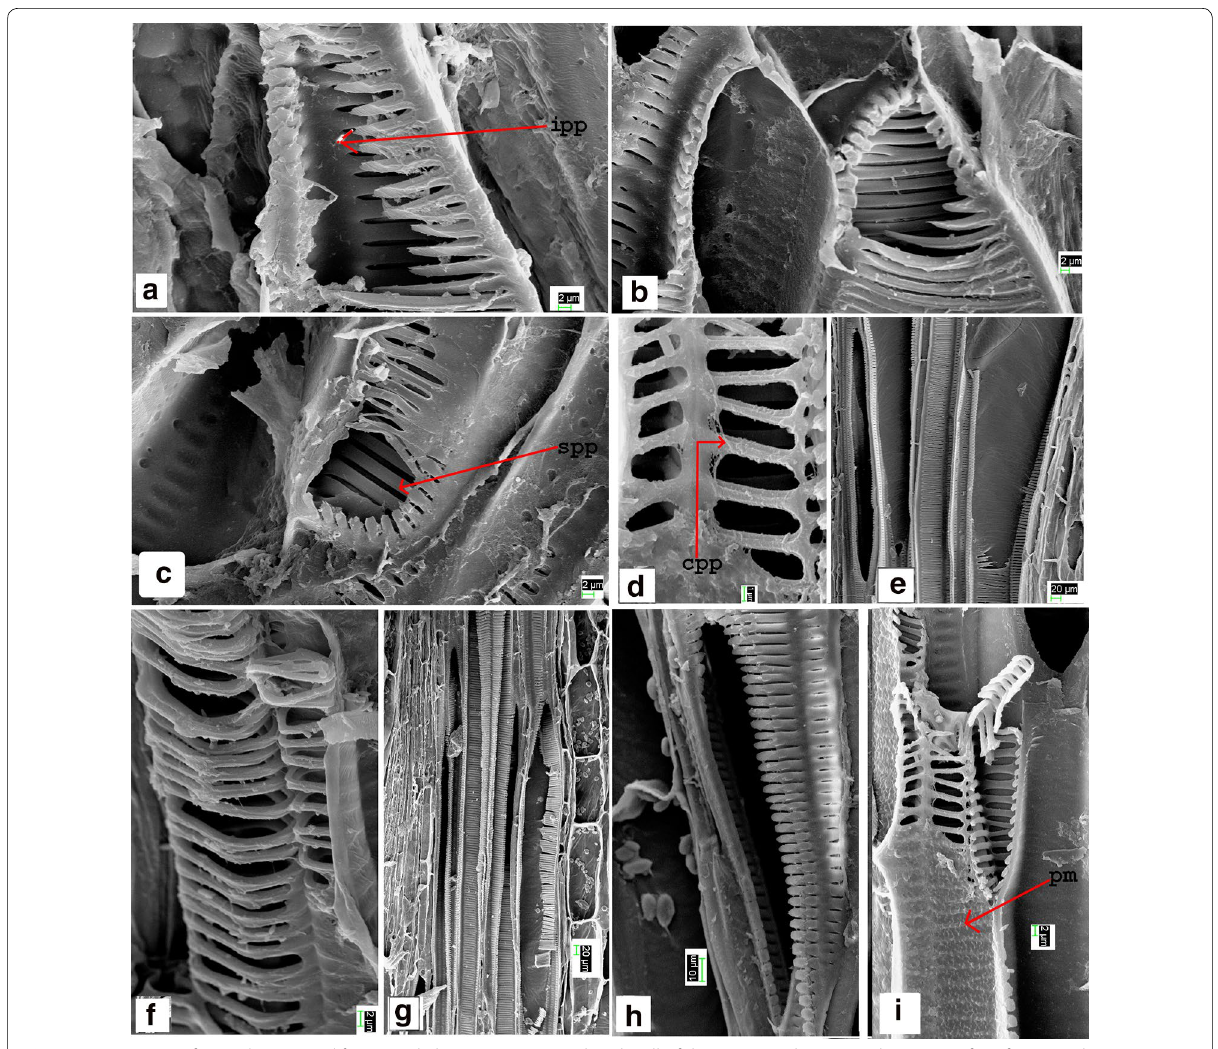
Fig. 4 SEM images of Ampelopteris prolifera -vessel elements. a – c Vessel end wall of rhizome a with intermediate type of perforation plate, scalariform bars half produced b with 2–3 remnant scalariform bars. c Simple perforation plate, d vessel endwall (root) with complex perforation plate. e Vessel element (rhizome) with elongated perforation plate. f Helically thickened tracheid. g Vessel element with enlarged endwall and intermediate perforation plate associated with xylem parenchyma. h Vessel endwall with simple perforation plate. i Endwall with compound perforation plate and lateral wall with pit membrane. (Abbreviations used: ipp intermediate perforation plate, spp simple perforation plate, cpp compound perforation plate, pm pit